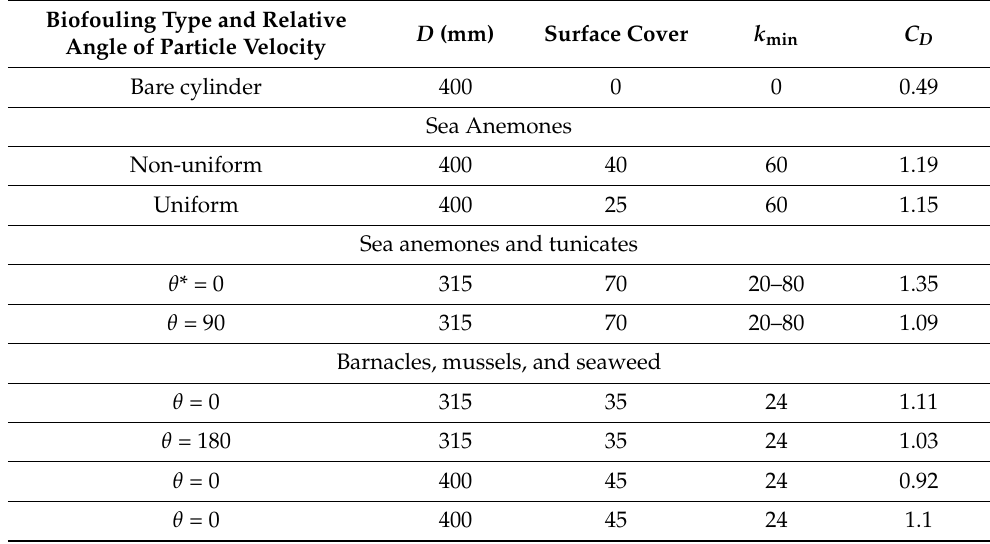
Table 2. Summary of soft and mixed fouling test results